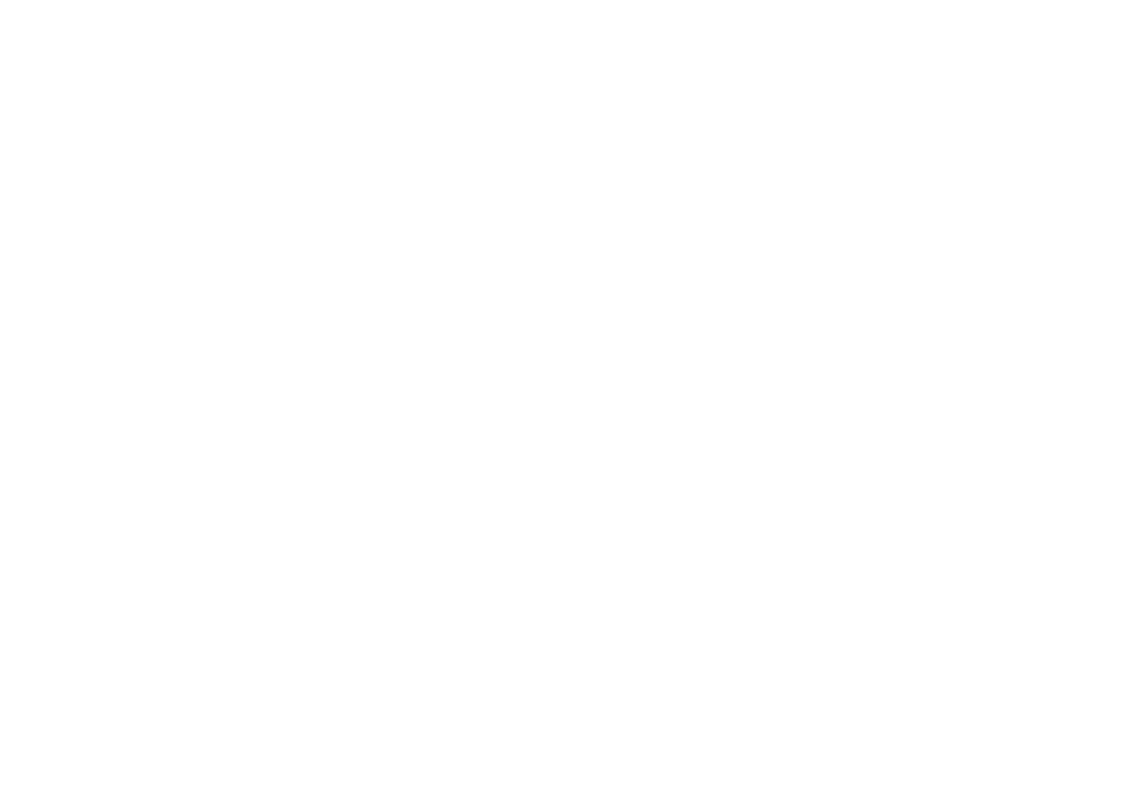
Overview, data collection, and analysis method not specified.